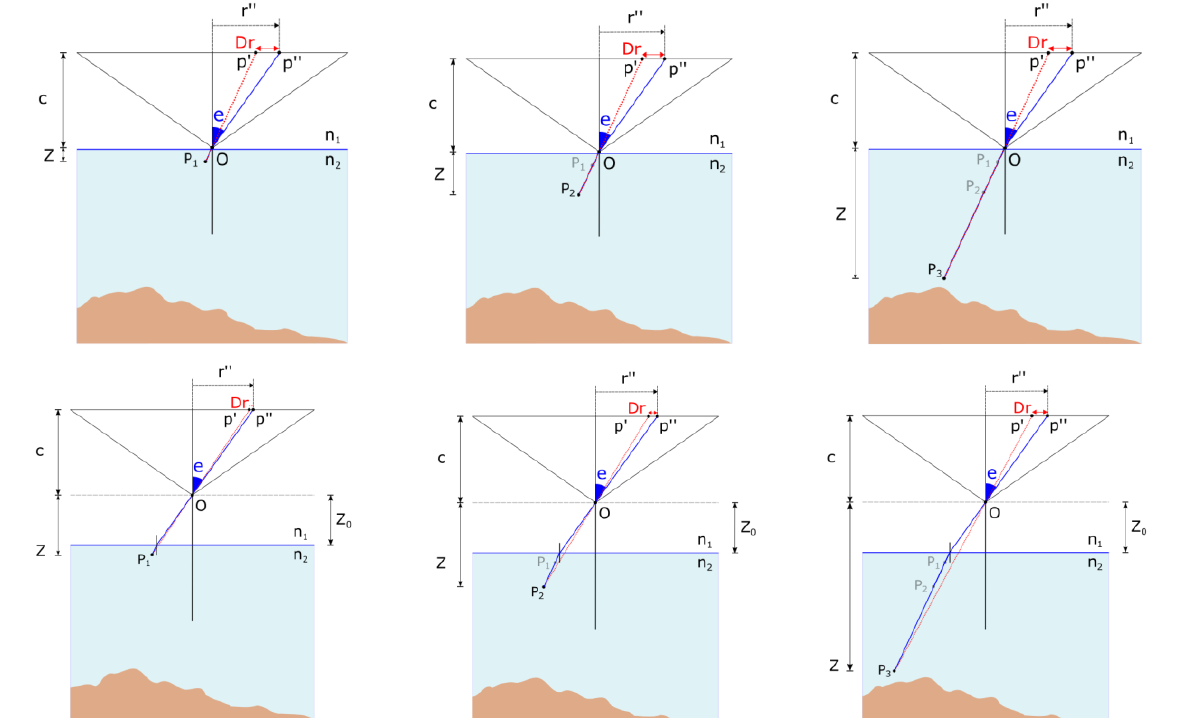
Figure 2 . Distance-dependent distortion. First row: points on the same straight line but at different distances from the camera entrance pupil are projected at the same radial position on the image plane. Second row: points on the same straight line but at different distance from the camera entrance pupil are projected at different radial position on the image